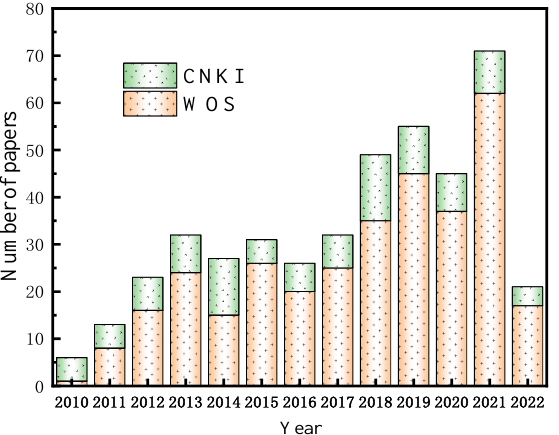
Figure 3. The number of literature sources related to wastewater treatment by DBD from 2010 to 2022.